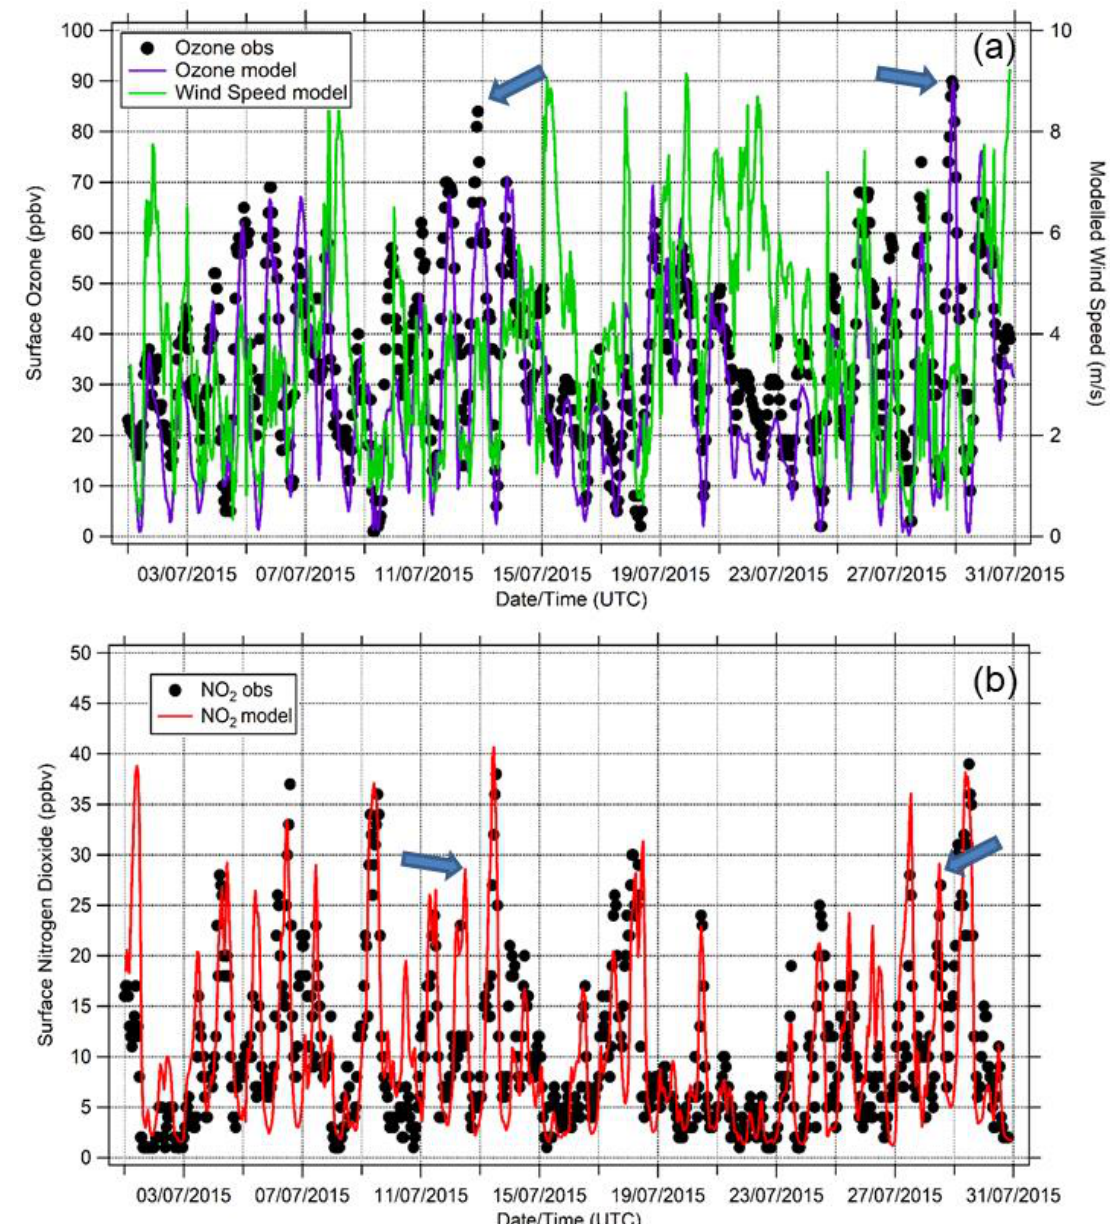
Figure 5. Modelled and measured hourly surface-level O 3 mixing ratio ( a ) and NO 2 mixing ratio ( b ) at the North Toronto site (in North York) for July 2015. The green trace is the modelled wind speed. The arrows mark the times for the two case study periods.